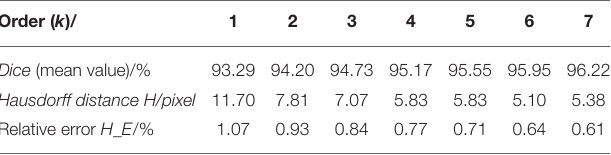
TABLE 1 | Calculation results of evaluation indices by modeling different orders of the Fourier method. Order ( k